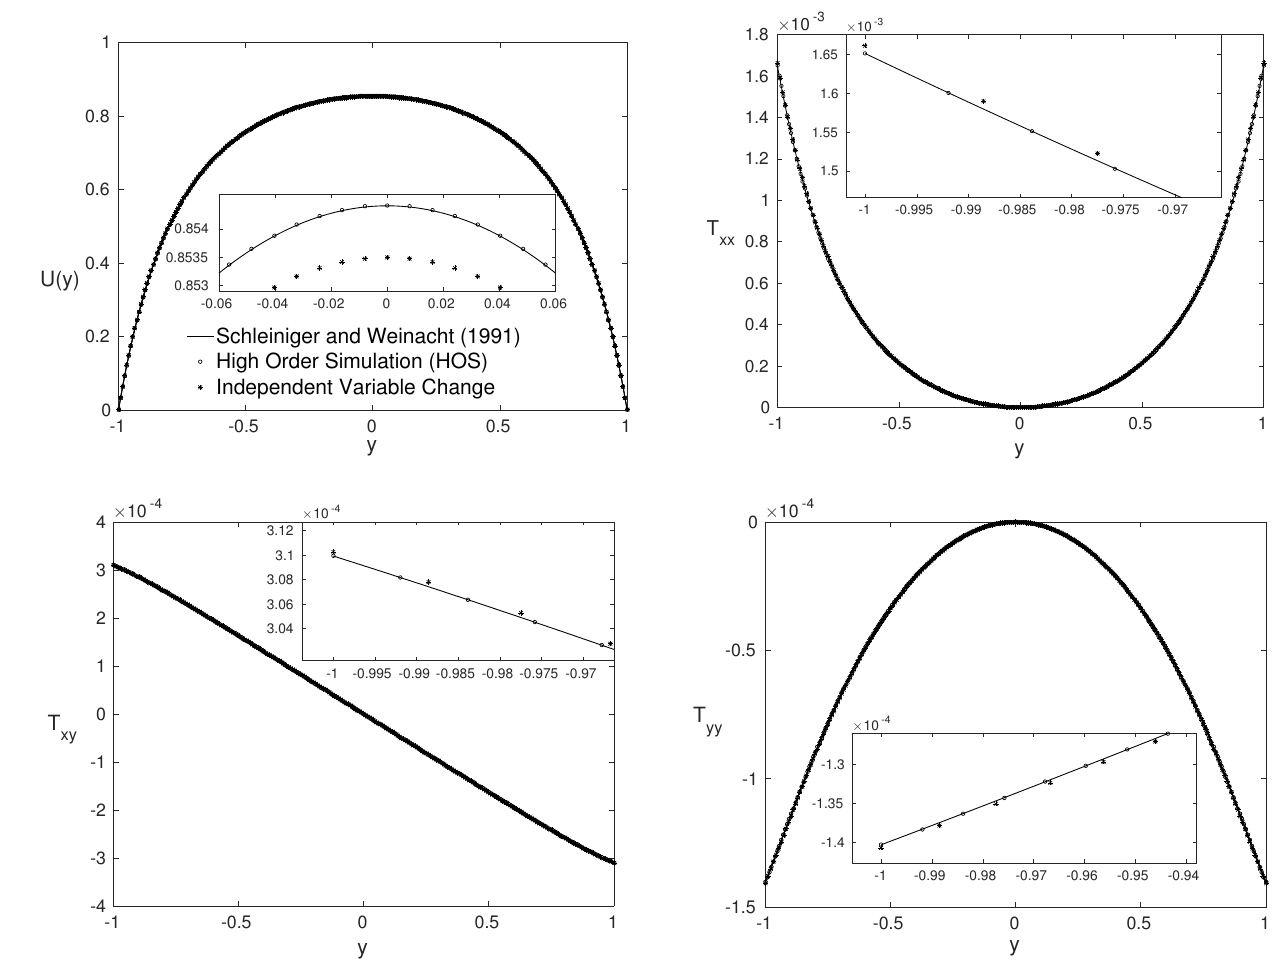
Figure 9. Same as in Figure 1 for dimensionless numbers: Re = 2000, β = 0.01, α G = 0.3 and Wi =